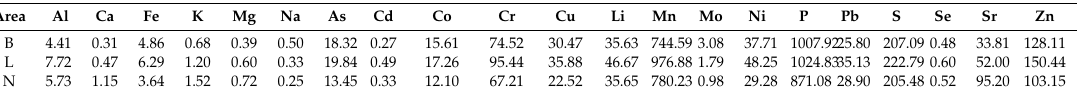
Table 5. Trace element and mineral levels in the soil environment in longevity and non-longevity counties in Hechi.